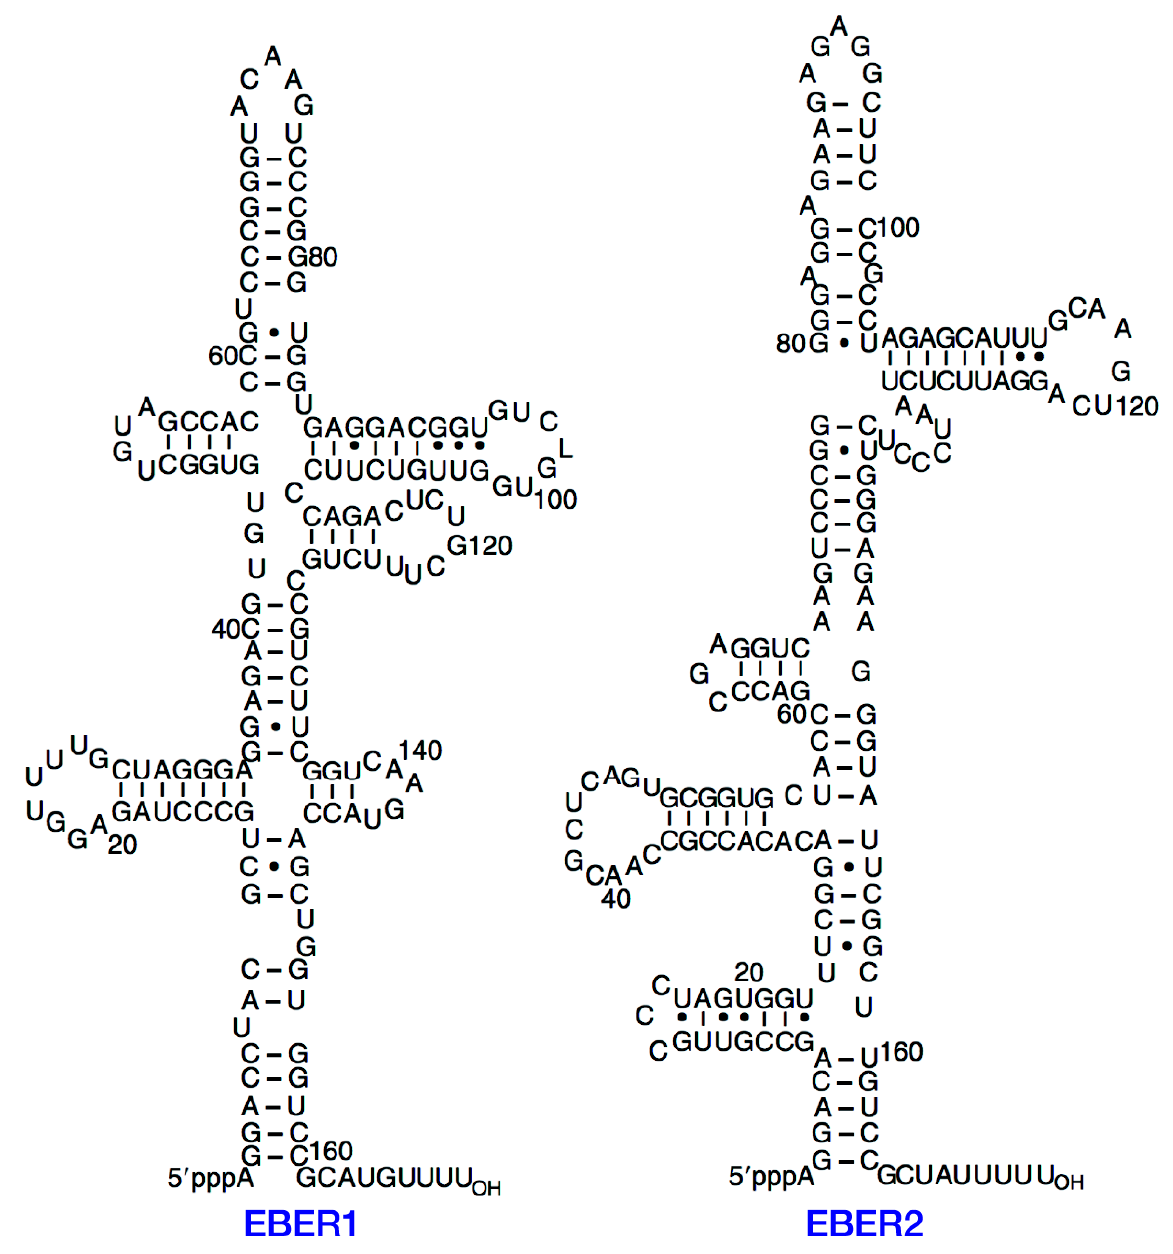
Figure 1. Secondary structures of EBERs. Reproduced from Rosa et al. [4]. EBER, Epstein-Barr virus-encoded